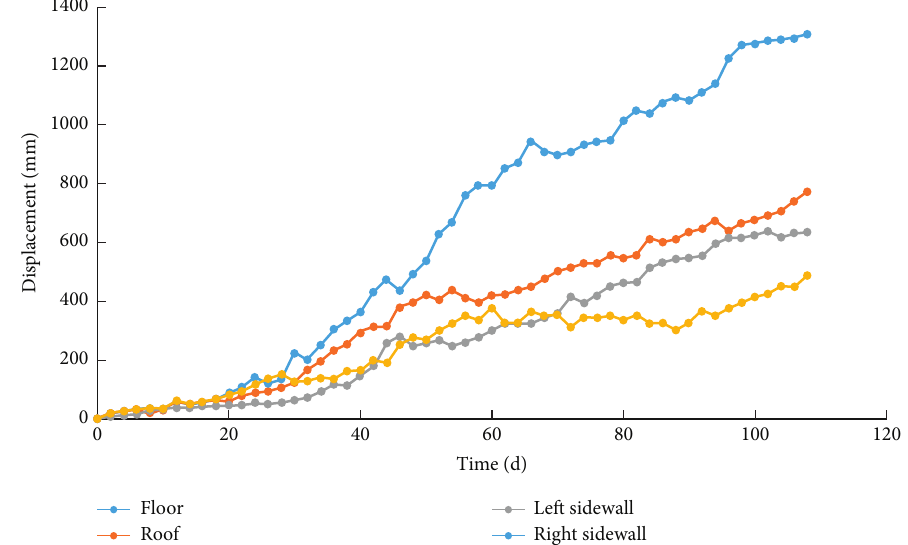
Figure 25: Measured displacement curve of #15 haulage